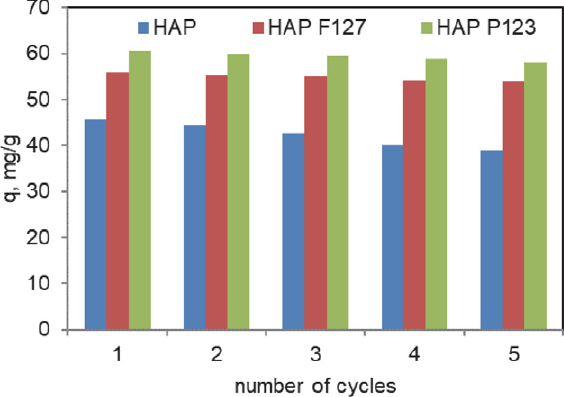
Figure 10. Cycles of desorption-adsorption for